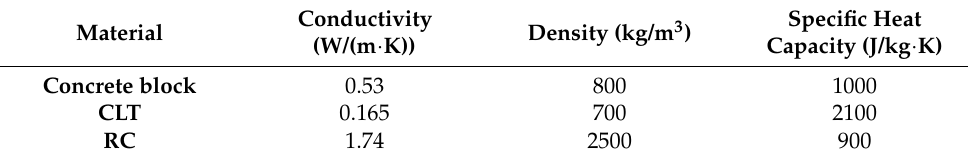
Table 7. Physical property parameters of the